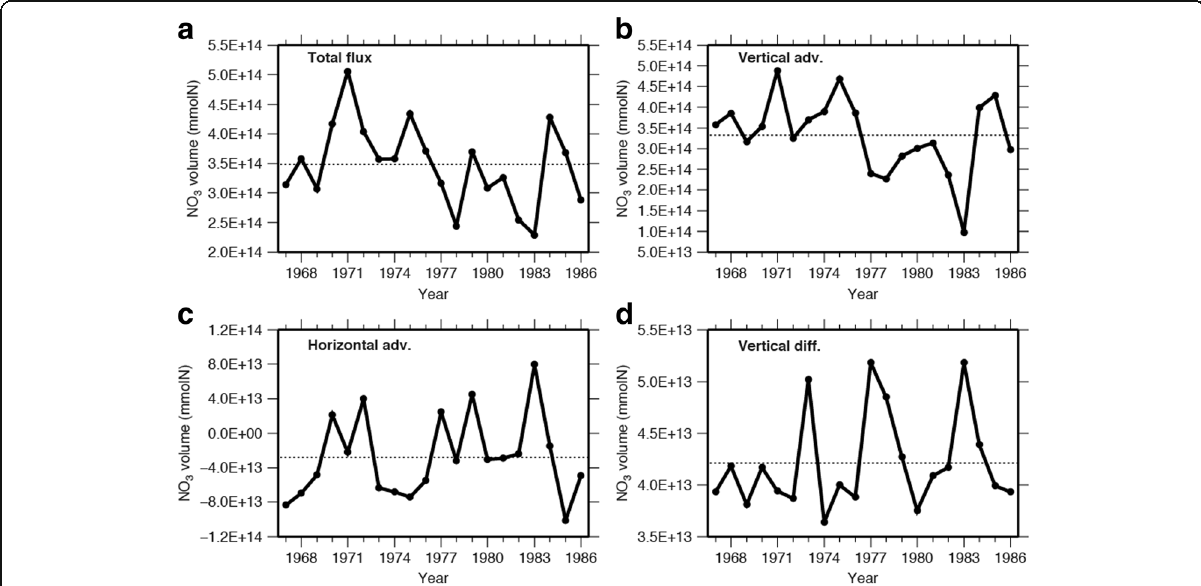
Fig. 14 Simulated time series of nitrate supply for 1967 to 1986 of the historical simulation. a Total nitrate supply, b nitrate supply by vertical advection, c nitrate supply by horizontal advection, and d nitrate supply by vertical diffusion into the coastal upper 30m of the water column integrated from October to April. Broken lines represent the values averaged over 1967 to